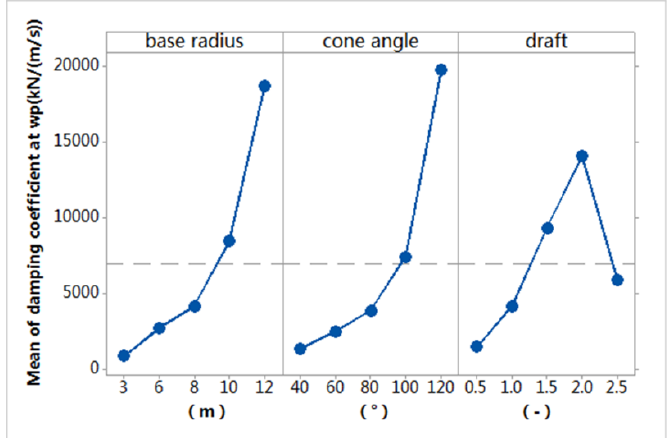
Figure 14. Main effects plot for radiation damping coefficient at peak frequency.